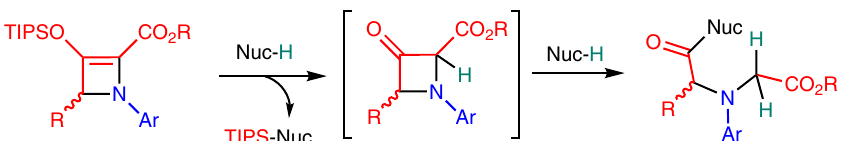
Fig. 3 Strain-induced nucleophilic ring opening of donor – acceptor azetines. Desilylation of the azetine forms the activated 3-azetidinone that undergoes nucleophilic retro-Claisen ring